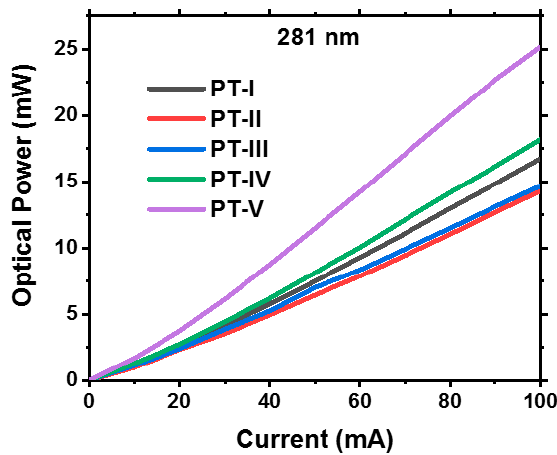
Figure 6. Optical power of 281 nm five PT DUV-LEDs.